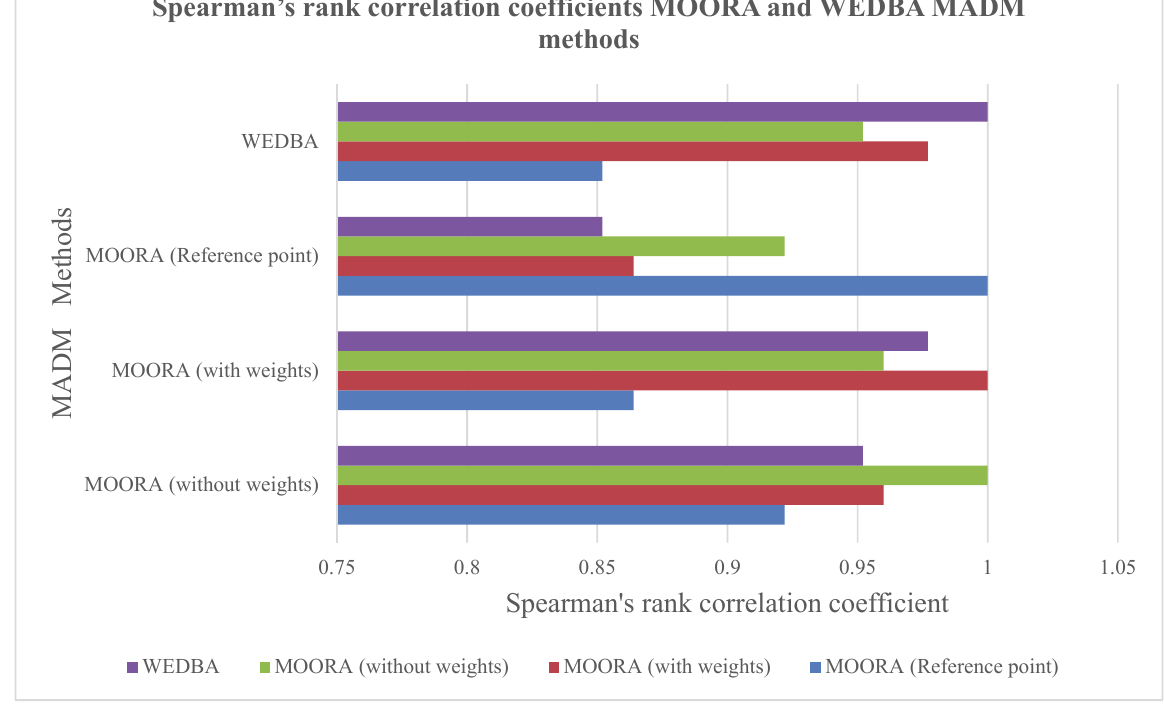
Fig. 6. Spearman’s rank correlation coefficients between MOORA and WEDBA MADM methods for ranking of flexibility of